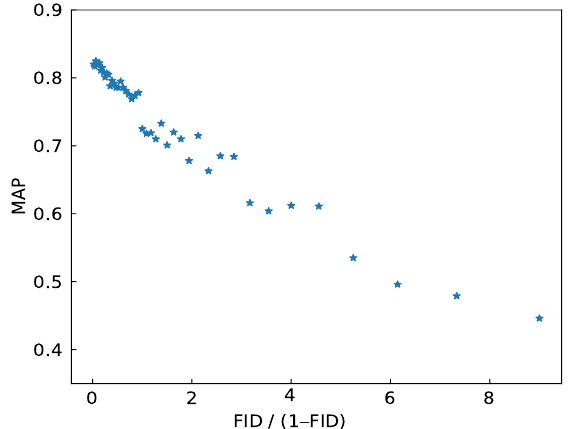
Fig. 7 MAP versus ORDI using P 1 at constant FUD= 0.5 for top 5 recommendations based on SVD estimated